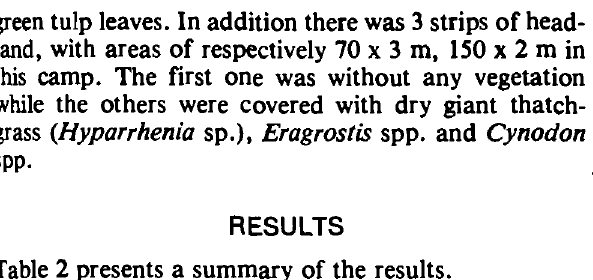
Table 2: RESULTS OF PROPHYLATIC TULP DOSING IN CATTLE - - -~--- .